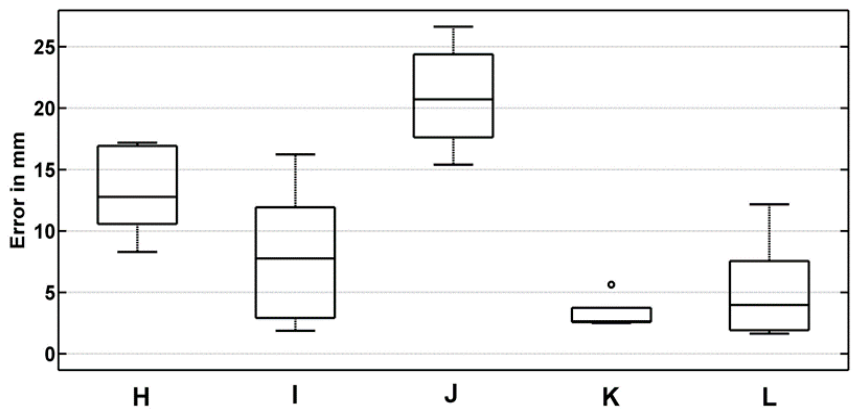
Figure 3. Box plot of mean errors between total station and photogrammetric 3D model using Pix4D for testing scenarios H-L.